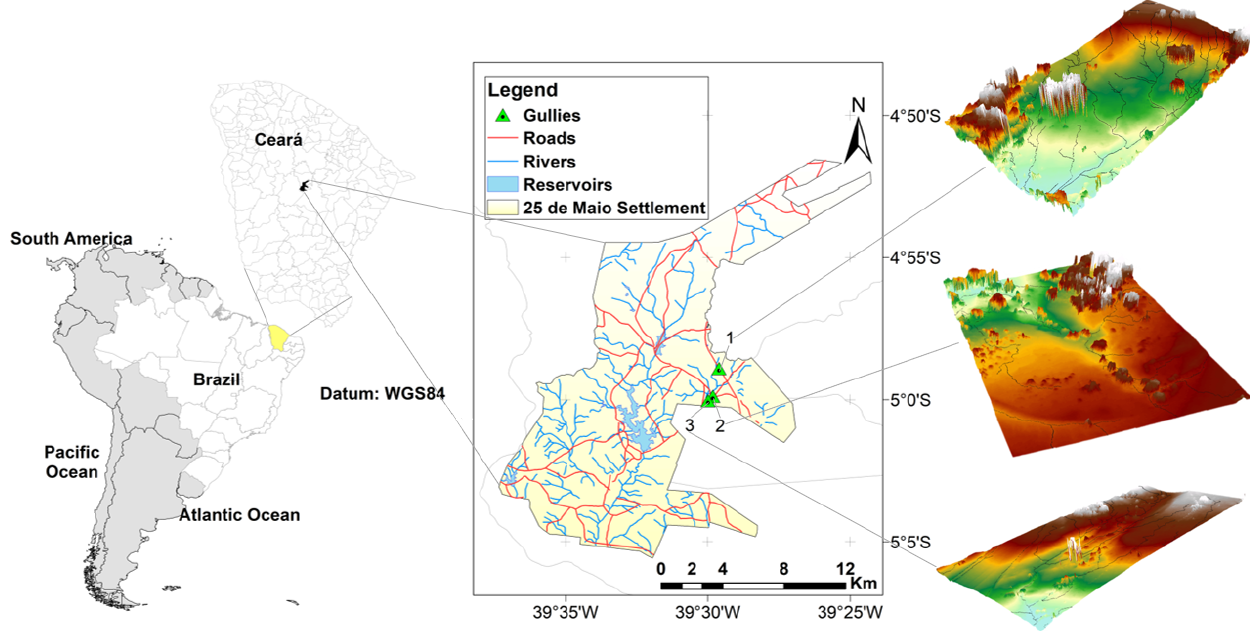
Figure 1. Location of the study area and the gully sites (gullies 1, 2 and 3) and the digital elevation models. The roads, rivers and reservoirs were mapped by Silva et al. (2015).